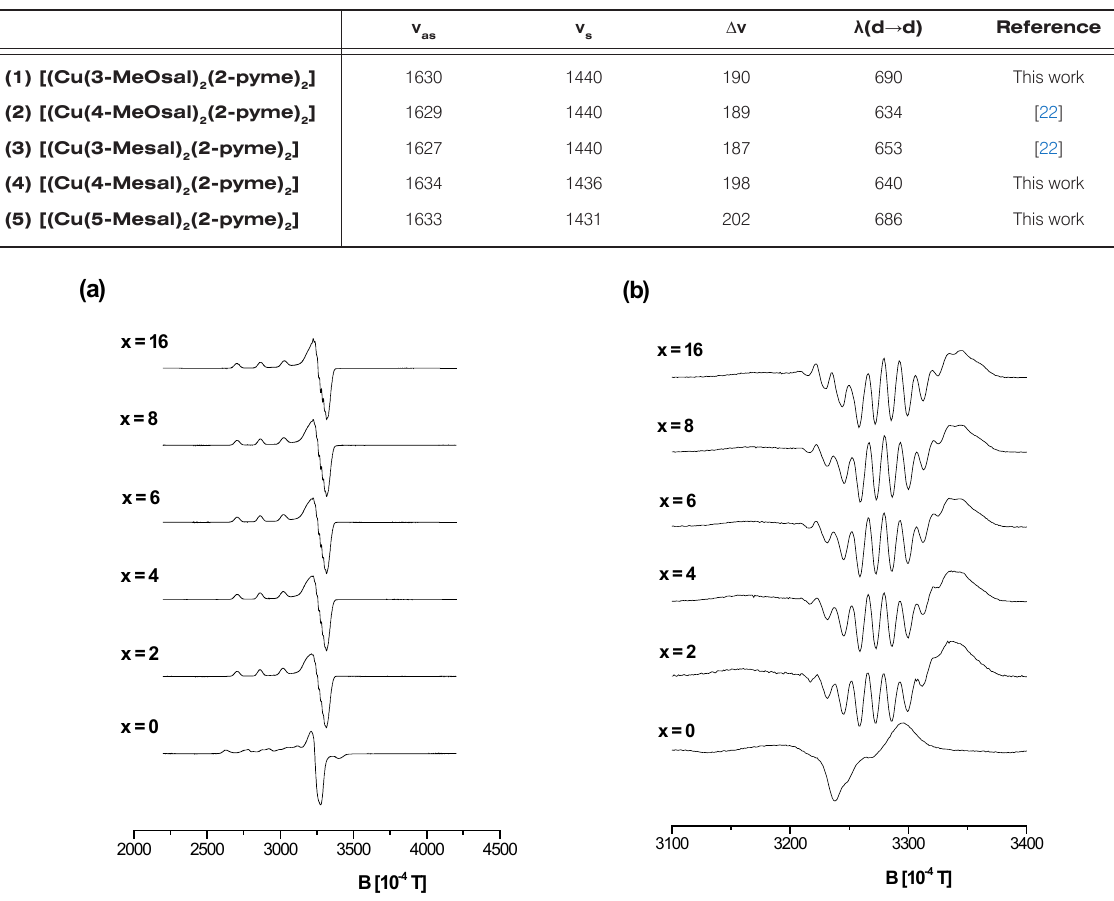
Figure 1. a ) Experimental first-derivative Cu(II) EPR spectra of system [Cu(ac) 4, 6, 8 and 16, measured in frozen water/methanol solutions at 98 K. b ) Expansion of perpendicular region with 14 N superhyperfine splitting of the second-derivative Cu(II) EPR